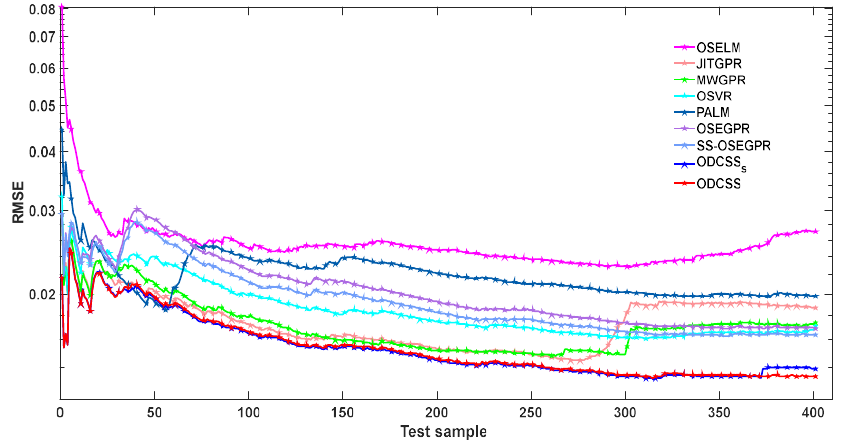
Figure 6. Comparison of RMSE trends of different soft sensor methods.